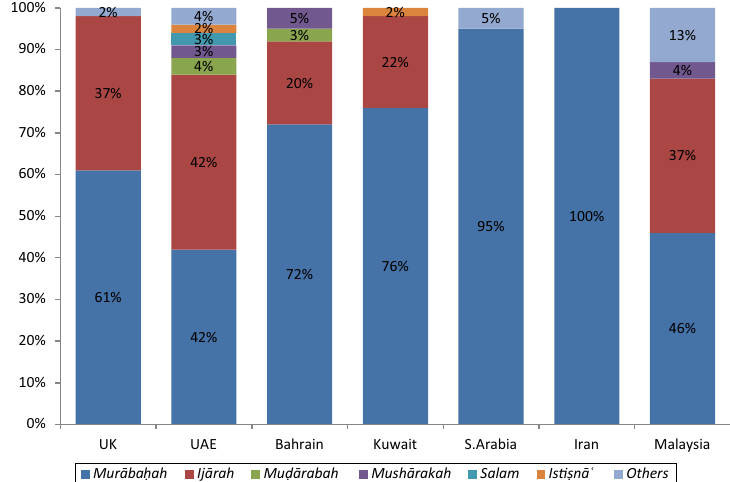
Figure 2. Use of Islamic banking